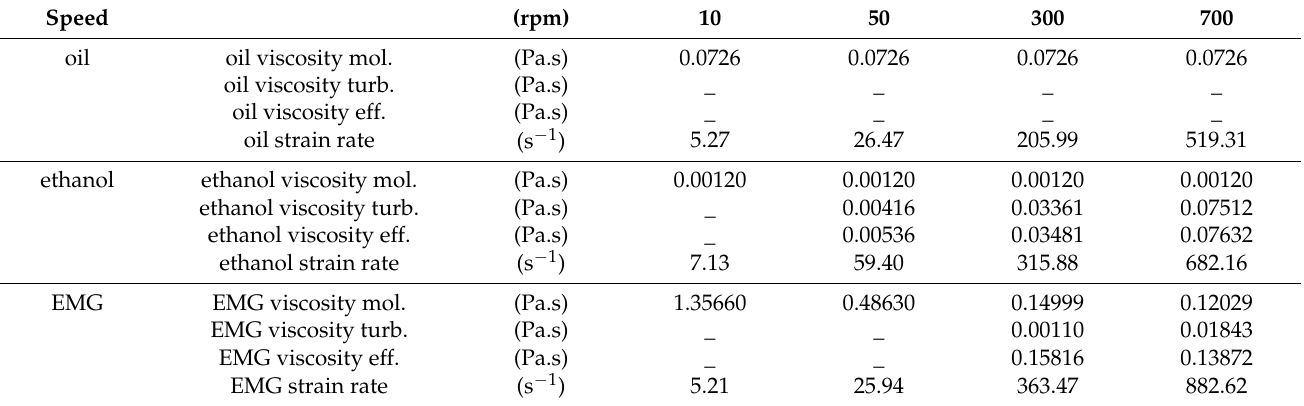
Table 5. Mean values of the viscosity mol., turb., eff. and strain rate.